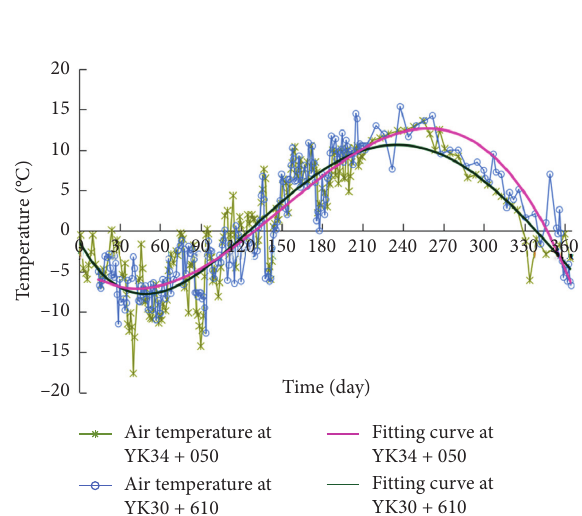
Figure 11: The air temperature curves outside the tunnel vs.